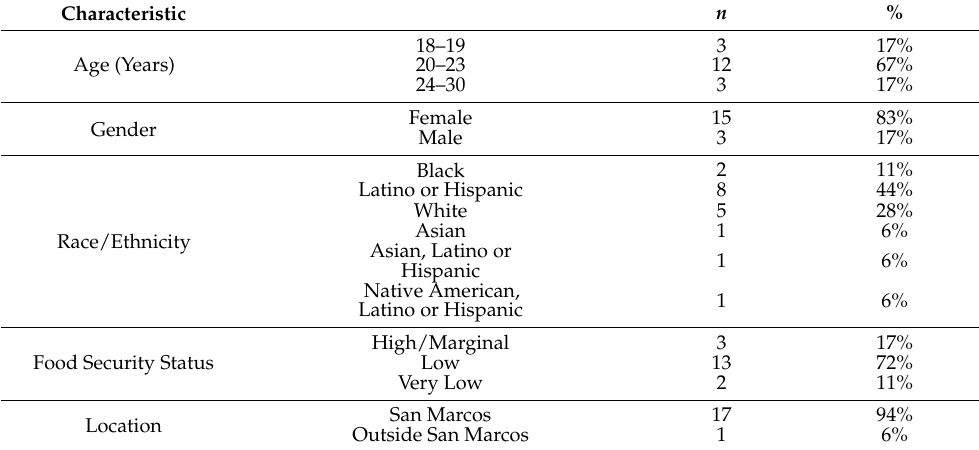
Table 1. Characteristics of HOME Study participants ( n =